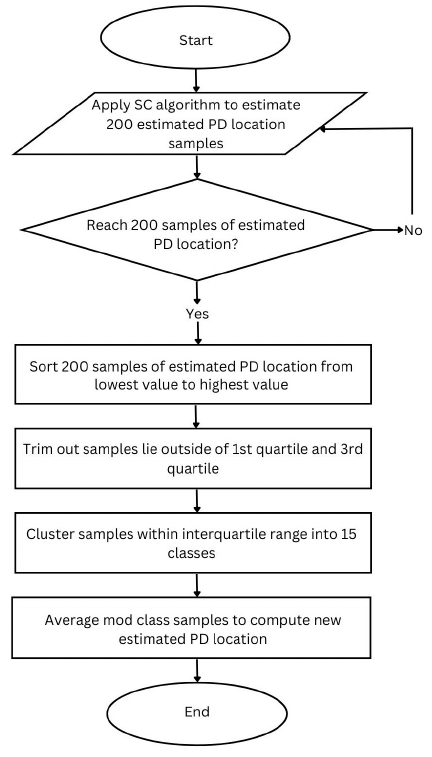
Figure 6. Process flow of the SCTM algorithm.